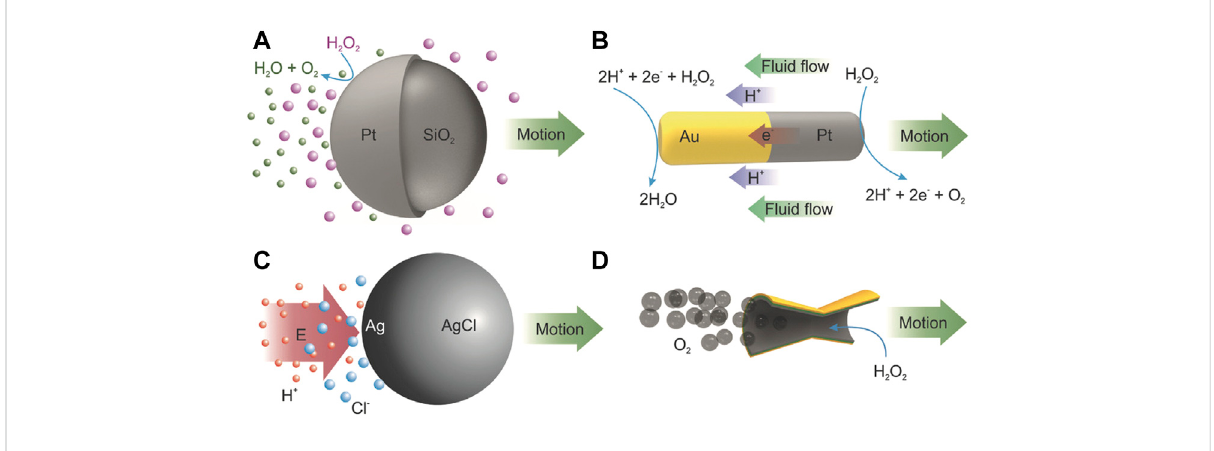
FIGURE 3 Chemical propulsion mechanisms (A,B) diffusiophoretic, (C) electrophoretic, and (D) bubble induced propulsion. Reproduced with permission (Safdar et al., 2018). Copyright (2018)